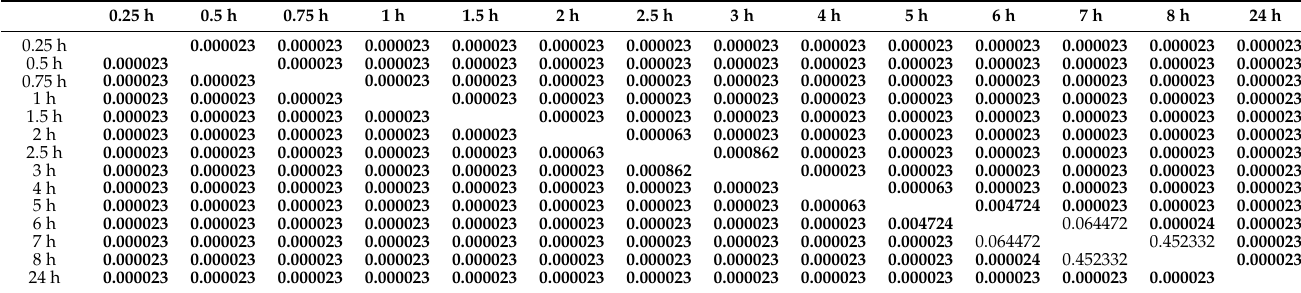
Table A5. Significant differences for the EMC variable for the effect of climatic chamber operation time (CCOT) according to Tukey’s test (HSD) for lemon peels.